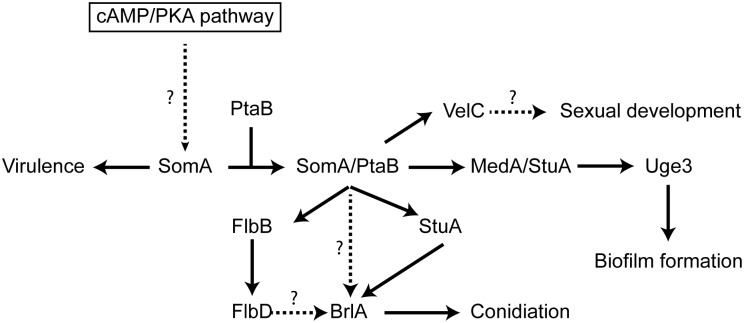
Model of the SomA and SomA-PtaB genetic network in A. fumigatus.The solid arrows indicate the presented data and the results of previous studies [25, 28–30, 56]. We showed that SomA/PtaB complex is a transcriptional activator for downstream targets (Fig 6 and S3 Fig) and these proteins had different cellular functions in A. fumigatus (See Discussion).